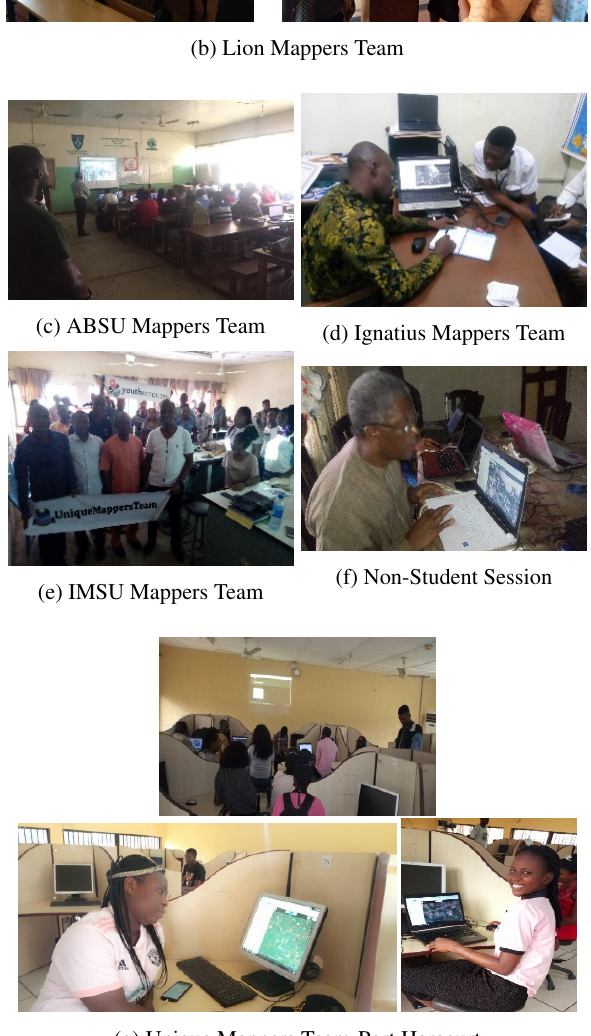
Figure 4: Sample Photographs of In-Person Training Sessions for LVM in Nigeria